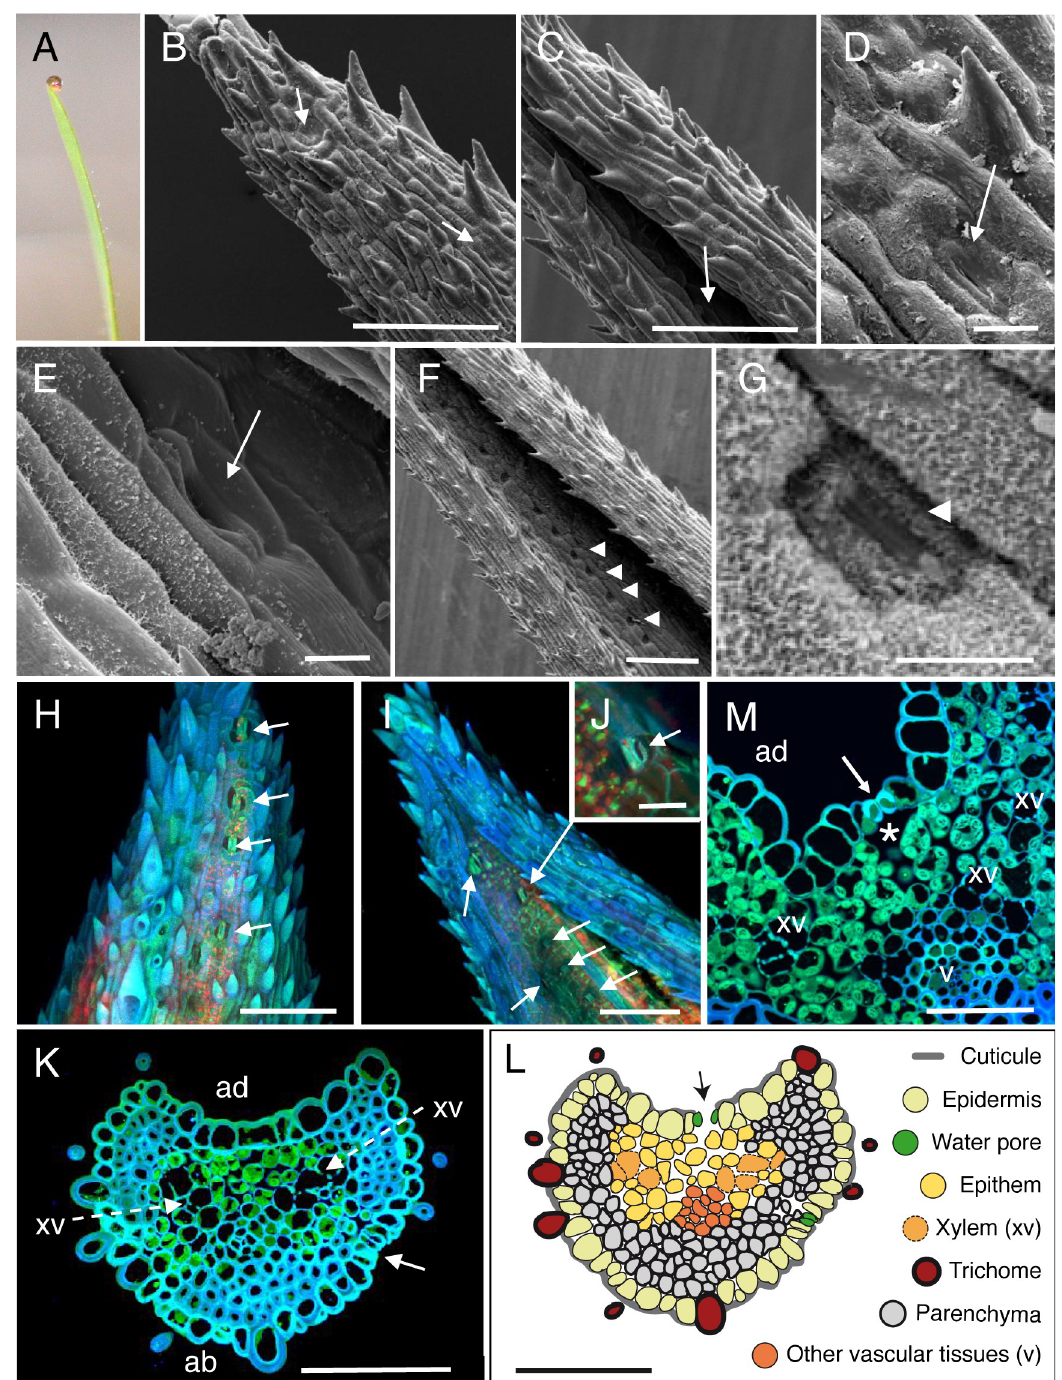
Fig 3. Anatomic description of Brachypodium distachyon apical hydathodes by confocal and Scanning Electron Microscopy (SEM). (A) A guttation droplet at the leaf tip. (B-E) The leaf tip was imaged by SEM. Water pores observed on the abaxial (B, D) and adaxial (C, E) faces of the leaf tip. (F-G) Observations of stomata were performed on distal parts of leaves relative to panels B-E. Panel G is a closeup image of panel E. (H-J) Confocal images of fresh leaf tips on their abaxial (H) and adaxial (I, J) faces. (K, M) Transversal sections (1- μ m thickness) of fixed tissue at 60–70 μ m (K) and 200 μ m (M) from the tip were observed by confocal microscopy. White arrows, arrowheads, dashed arrows and asterisk indicate water pores, stomata, xylem vessels (xv) and large chambers and intercellular spaces, respectively. v, small veins; ad, adaxial face; ab, abaxial face. (L) Schematic drawing of an hydathode cross section as observed in K. Scale bars: B-C, F, H-I: 100 μ m; K-M: 50 μ m; J: 20 μ m; D-E, G: 10 μ m.